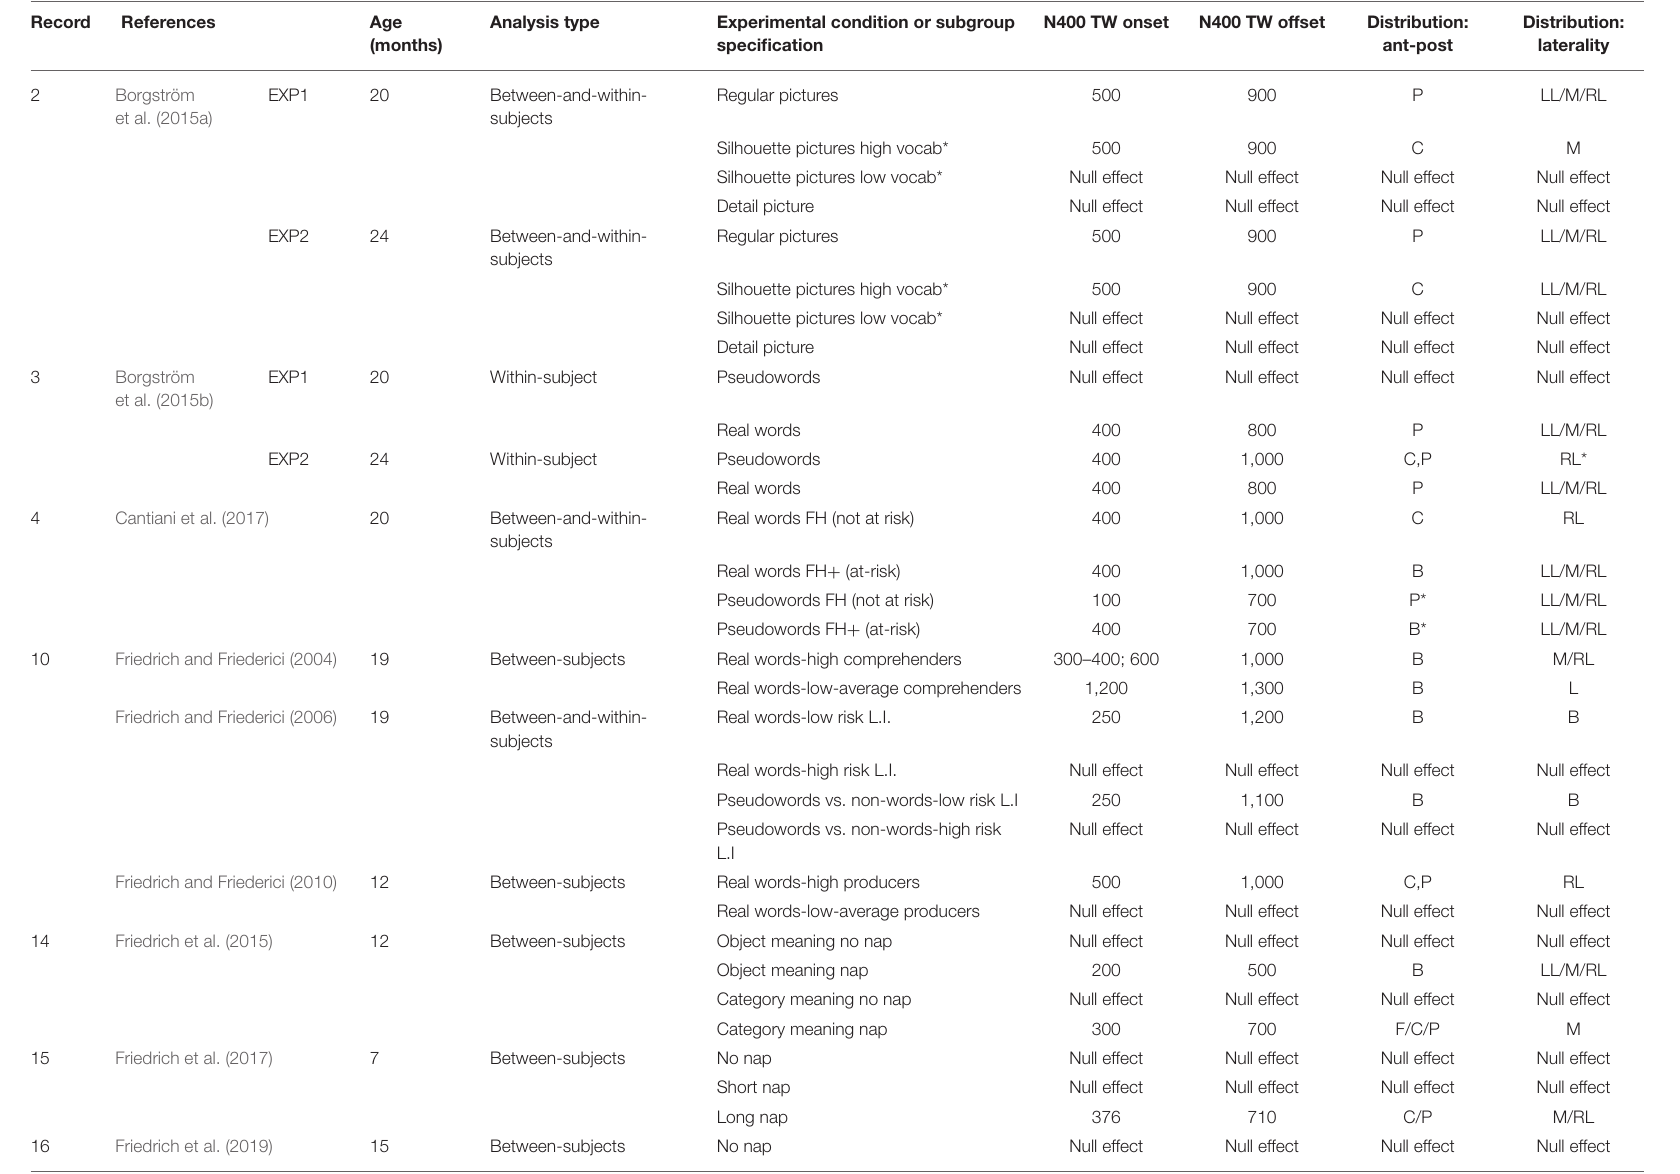
TABLE 2 | List of subgroups and condition analyses within papers listed in Table 1